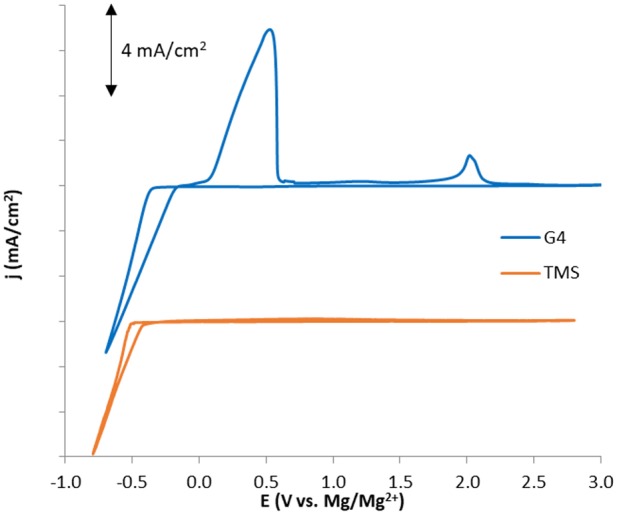
Cyclic voltammograms for 0.5 M MgTFSI2 solutions in G4 and TMS illustrating significant differences in Coulombic efficiency consistent with computed differences in solvent stability during Mg plating/stripping.